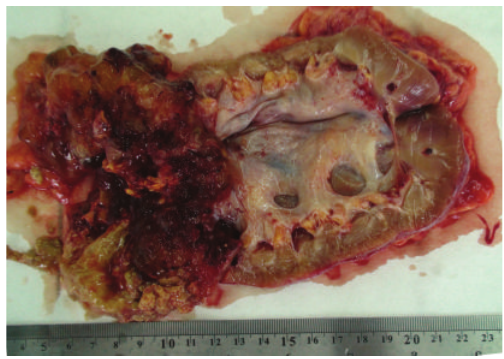
Figure 2: Grossly, a tumor which was 7cm in size originated from renal pelvis and expanded to the upper pole. The mass was filled with chocolate color mucinous